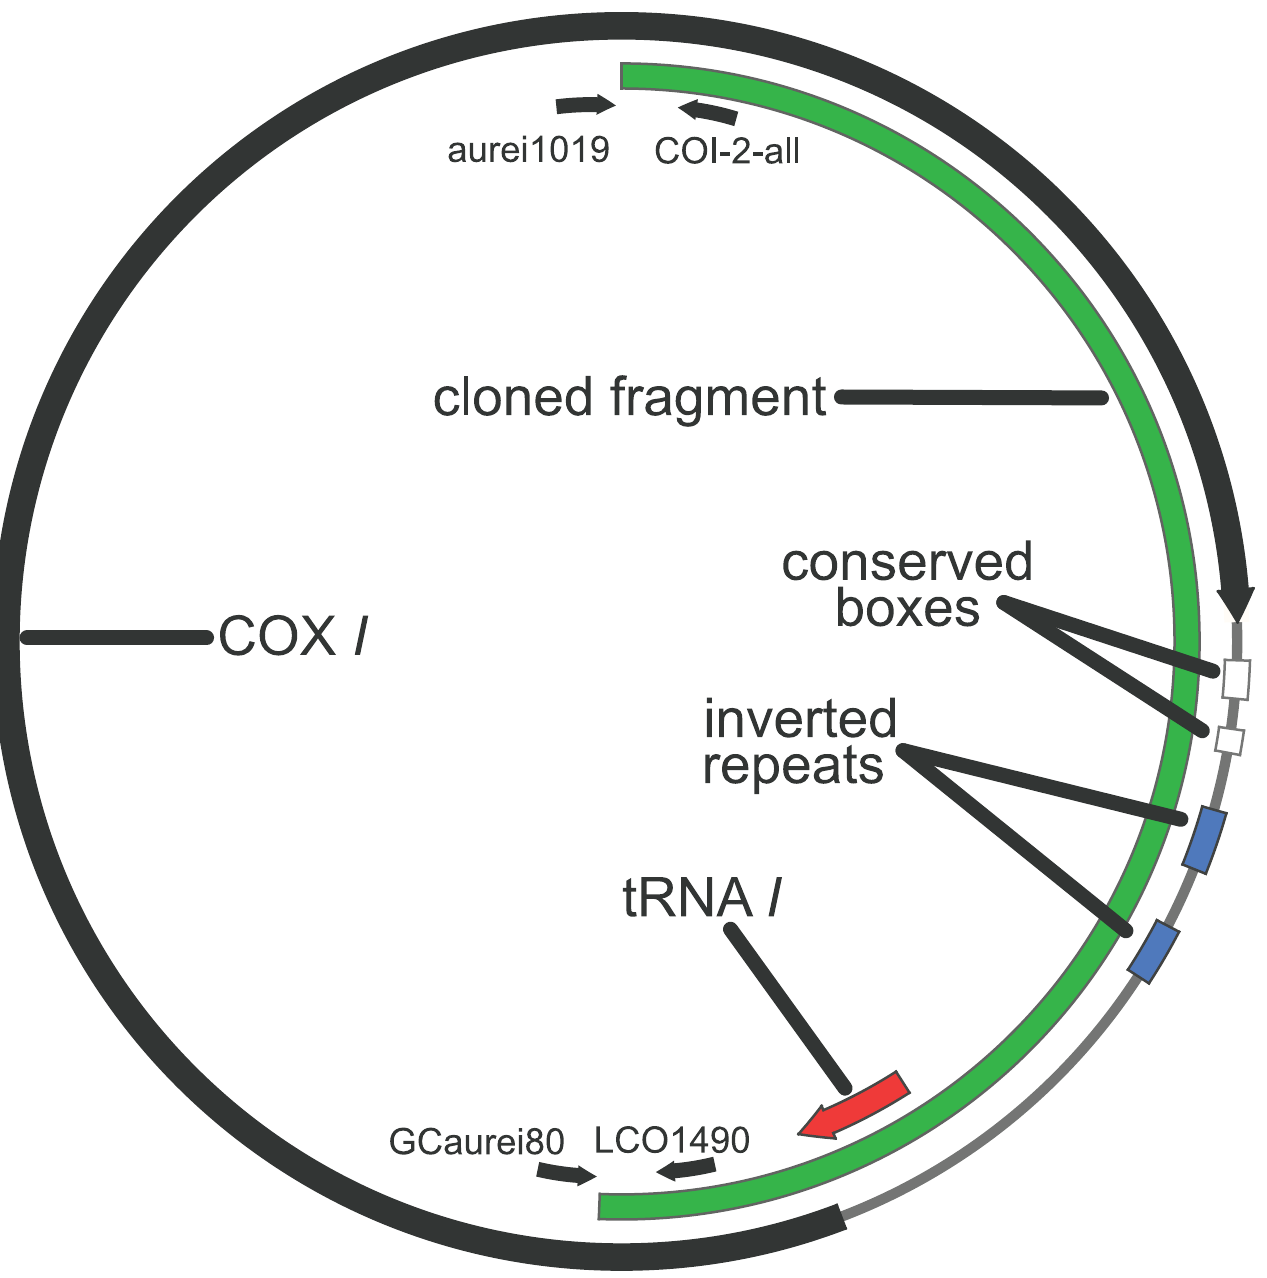
Fig 1. Geomydoecus aurei cox1 Minichromosome. Fully constructed minichromosome showing the relative positions of the cox1 gene, trn I , inverted repeat regions, PCR primers (shown as small black arrows), and the cloned region of the chromosome.